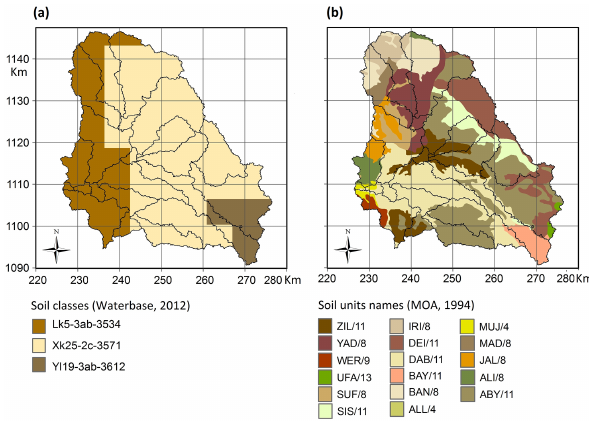
Figure 4. Soil classification of the Wala catchment: (a) Water- Base (2013); (b) Tarawneh